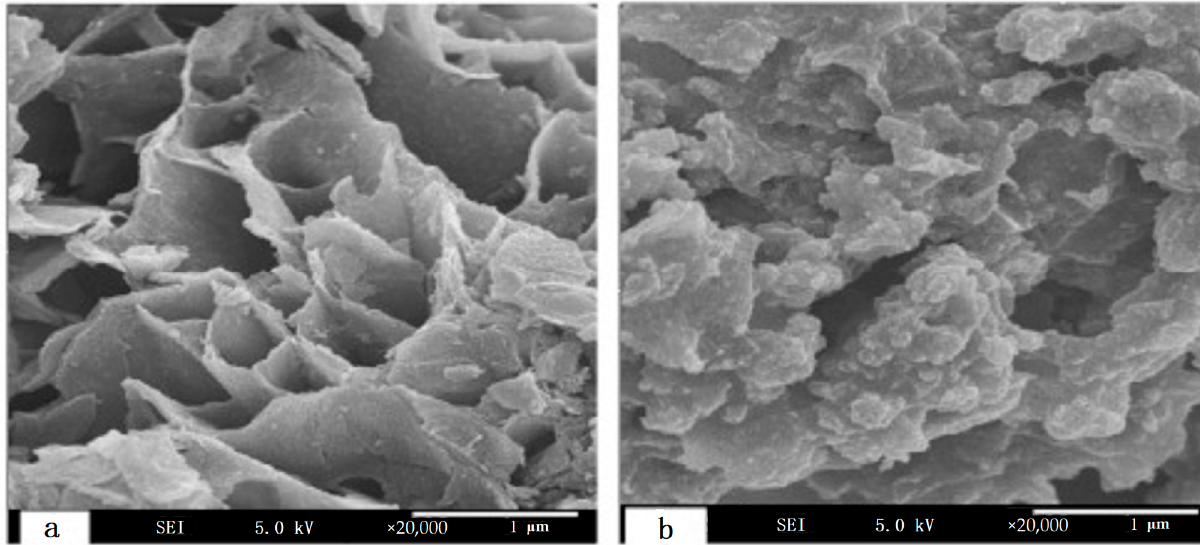
Figure 8. SEM micrographs of Fe 3 O 4 and SiO 2 composite magnetic powder ( a ) and PEI-grafted adsorbent ( b ). (Reproduced with permission from [85]; Copyright Elsevier, 2011).